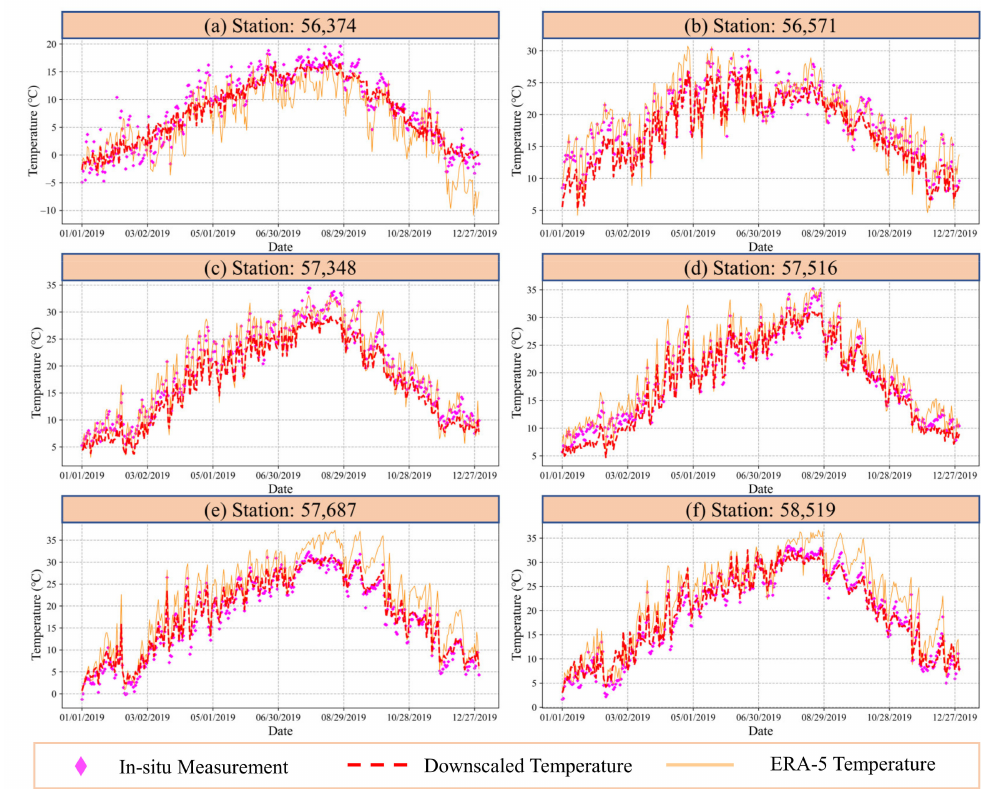
Figure 7. The temporal variations of the temperature data in 2019 at six randomly selected stations. The purple points represent in-situ ground measurements while the red dashed line and orange line indicate the downscaled temperature and ERA-5 temperature, respectively.